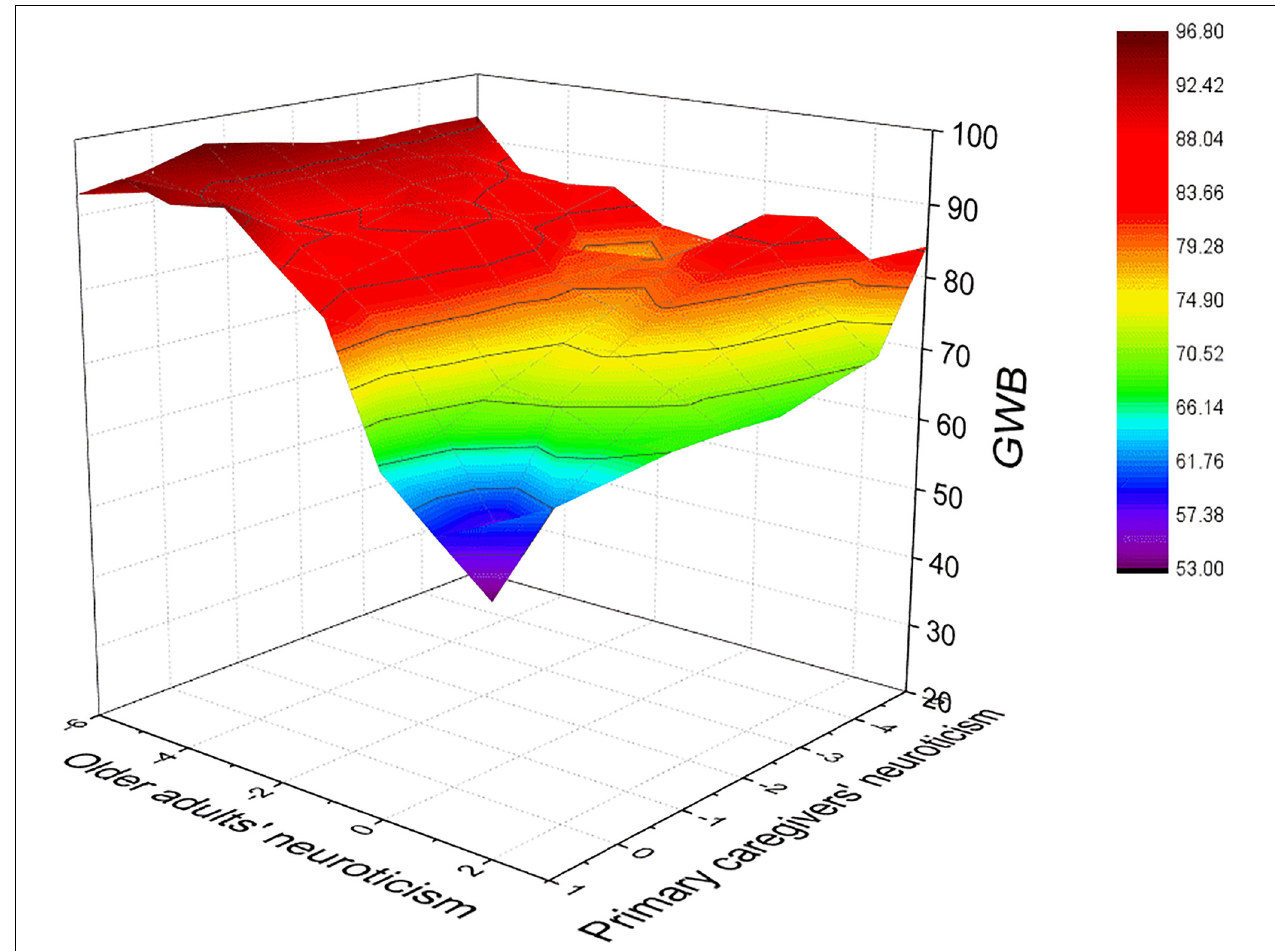
FIGURE 1 | Response surface graph depicting the neuroticism congruence/incongruence effects between older adults and primary caregivers on